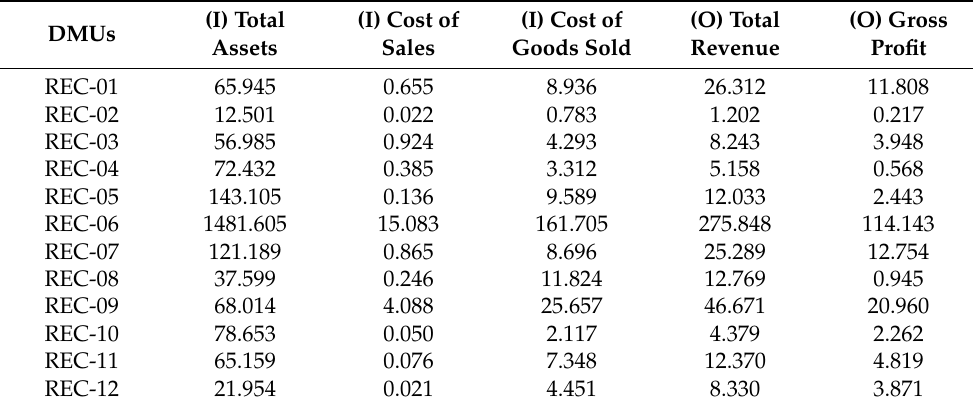
Table A2. The historical data of the year 2016, (unit: million